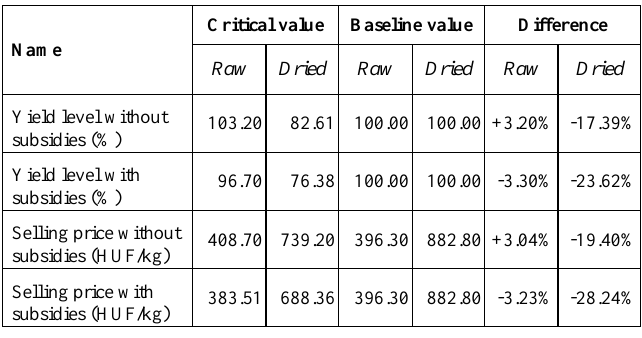
Table 13. Critical values of factors affecting income with and without investment subsidies (NPV = 0)